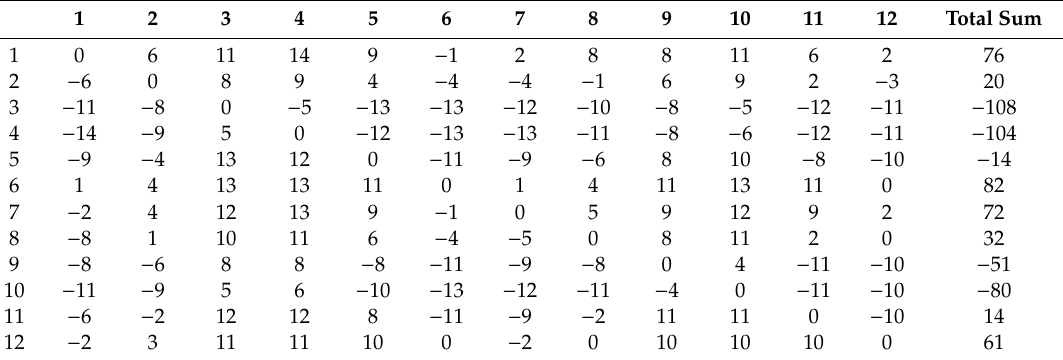
Table 9. Results of the Mann–Whitney U test, the population size is 50.